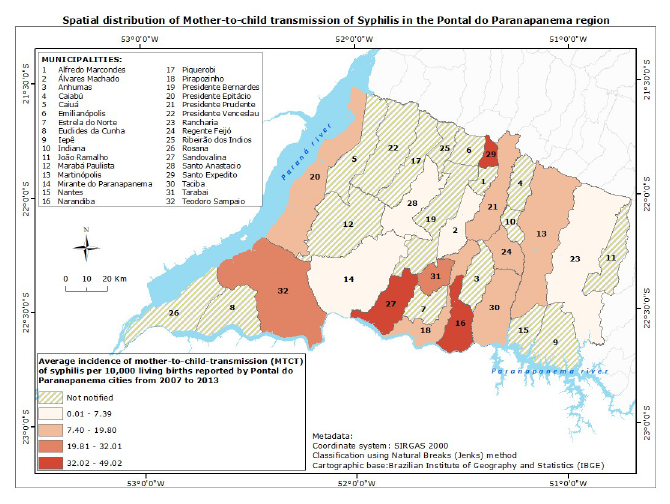
Fig 7. Pontal do Paranapanema cities and the spatial distribution of mother-to-child transmission (MTCT) of syphilis reported cases from 2007 to 2013. The highest incidences of cases were represented by Sandovalina, Narandiba e Santo Expedito (black) followed by Tarabai and Teodoro Sampaio (burgundy). Presidente Prudente, Regente Feijo´ and Martino´polis reported an index of 7.54 to 15.25 (salmon) and, the lowest index average incidences were identified in Santo Anasta´cio, A ´ lvares Machado, Rancharia e Mirante do Paranapanema (salmon). Cities that reported cases of MTCT of syphilis are located mainly in the border with Parana state (South). Databases: Brazilian Institute of Geography and Statistics—IBGE (2010) and National System of Aggravations and Notification–SINAN (2017).